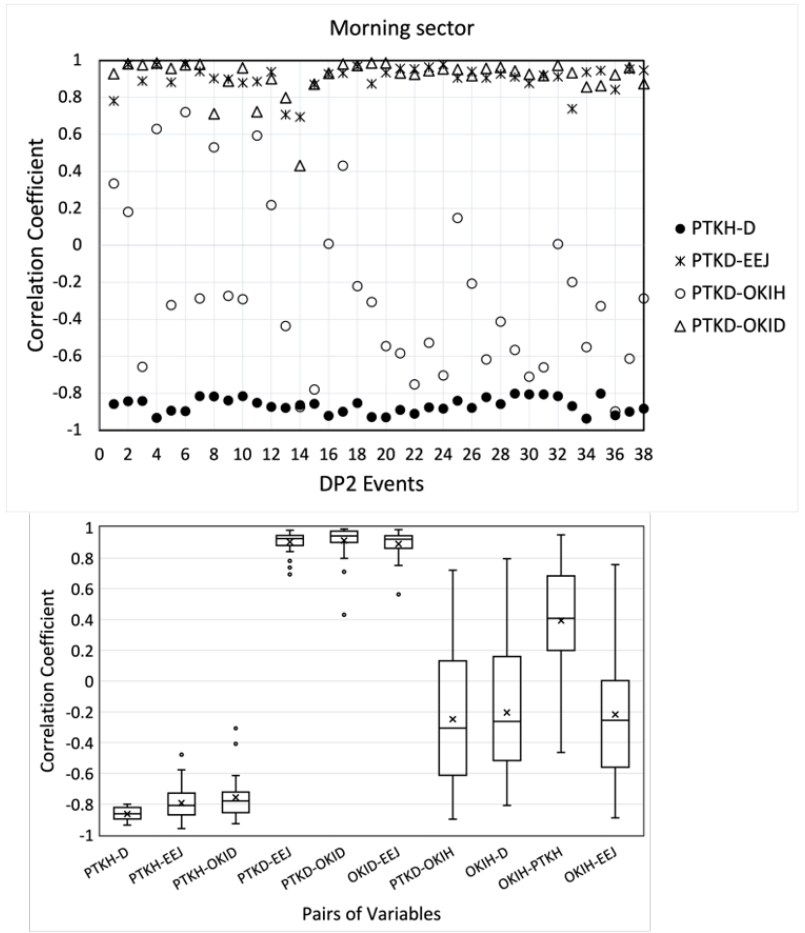
Figure 3. ( top ) Scatter plots of correlation coefficients between PTKD and other variables of 39 DP2 events in the morning sector; cc ( PTKH-D ), cc ( PTKD-EEJ ), cc ( PTKD-OKIH ), and cc ( PTKD-OKID ). ( bottom ) Box plots of all the correlation coefficients between two variables, composed of the minimum, lower quartile, median, upper quartile, and maximum with outliers (dots). The average value is indicated by x inside the box.